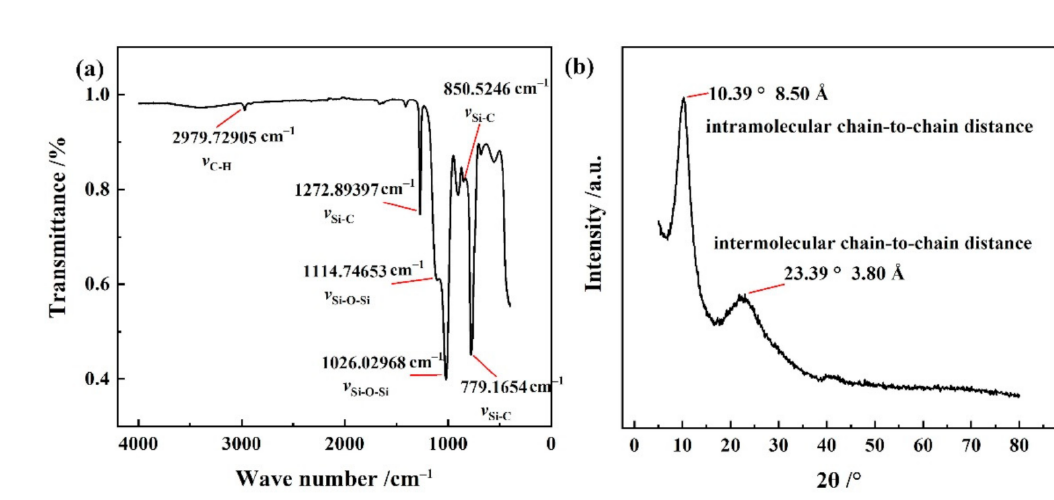
Figure 7. The chemical structure characterization of as-prepared PMSQ microparticles. ( a ) FT-IR spectrum, ( b ) XRD pattern.